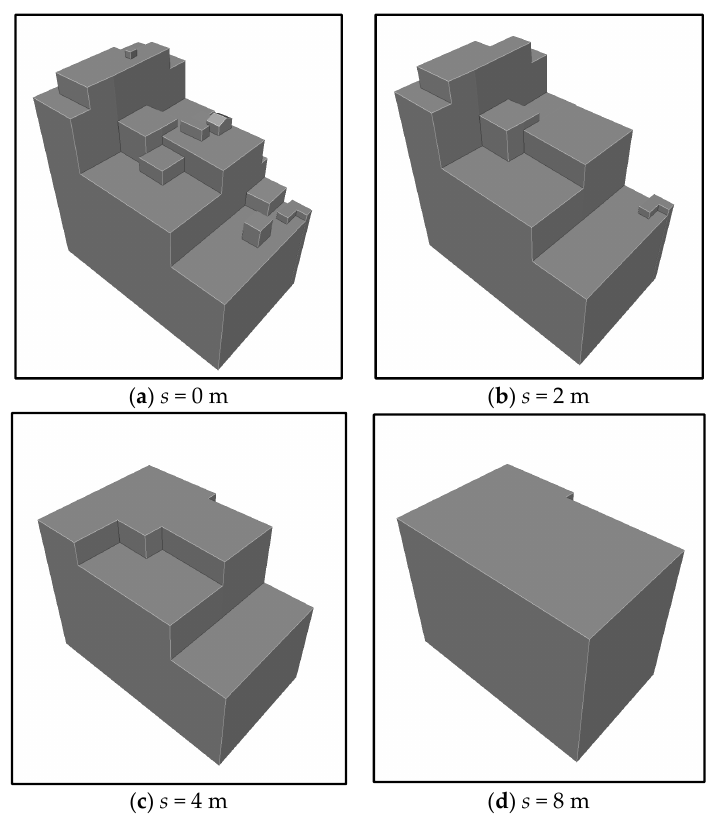
Figure 13. Reconstructing the building LoDs of the building candidate region PB in Figure 10c, where there are four levels. The roof structures are changed from complicated to simple with the increasing scale. ( a ) The building model within the scale of 0 m. ( b ) The building model within the scale of 2 m. ( c ) The building model within the scale of 4 m. ( d ) The building model within the scale of 8 m. The high quality of building point detection results was the prerequisite for reconstructing building LoDs in a scene. Hence, the result of building point detection was submitted to the organization ISPRS for evaluation [38]. The evaluation result is shown in Figure 15, and the details can be found on the website [39]. Several indicators are adopted for quantitative evaluation, including Completeness ( (cid:1829)(cid:1842) ), Correctness ( (cid:1829)(cid:1844) ) and Quality ( (cid:1843) ) at the pixel or object level, and the total Root Mean Square (RMS) of reference boundaries. The result is listed in Table 5. It can be seen that the Correctness values are 95.5% at the pixel level, and 96.6% at the object level. The high values show that the proposed method can robustly distinguish buildings from vegetation or other objects. It may benefit from the combination of features derived from the local and the whole of an object. In this result, there are only two false positives at the object level. The false positives are large objects with smooth surfaces, which are very easily classified as buildings. The Completeness values are 94.7% at the pixel level, and 98.3% at the object level. The values indicate the method could robustly extract buildings, as shown in the yellow areas of Figure 15. Additionally, the proposed method could also preserve annex structures and rooftop furniture well by taking large parts of the building and small structures as a whole in the process of detecting buildings, and robustly removing noise and vegetation points on the roofs, as illustrated in Figure 16. In order to further analyze the performance of the proposed method, the comparison between the proposed method and the other methods [13] is listed in Table 5, showing that the proposed method has the best qualities in detecting buildings at the pixel level and the total RMS, and only the method of FIE [40] obtained a better performance than the proposed method at the object level. Therefore, the result of building point detection could provide a good foundation for the reconstruction of building LoDs. However, some small segments